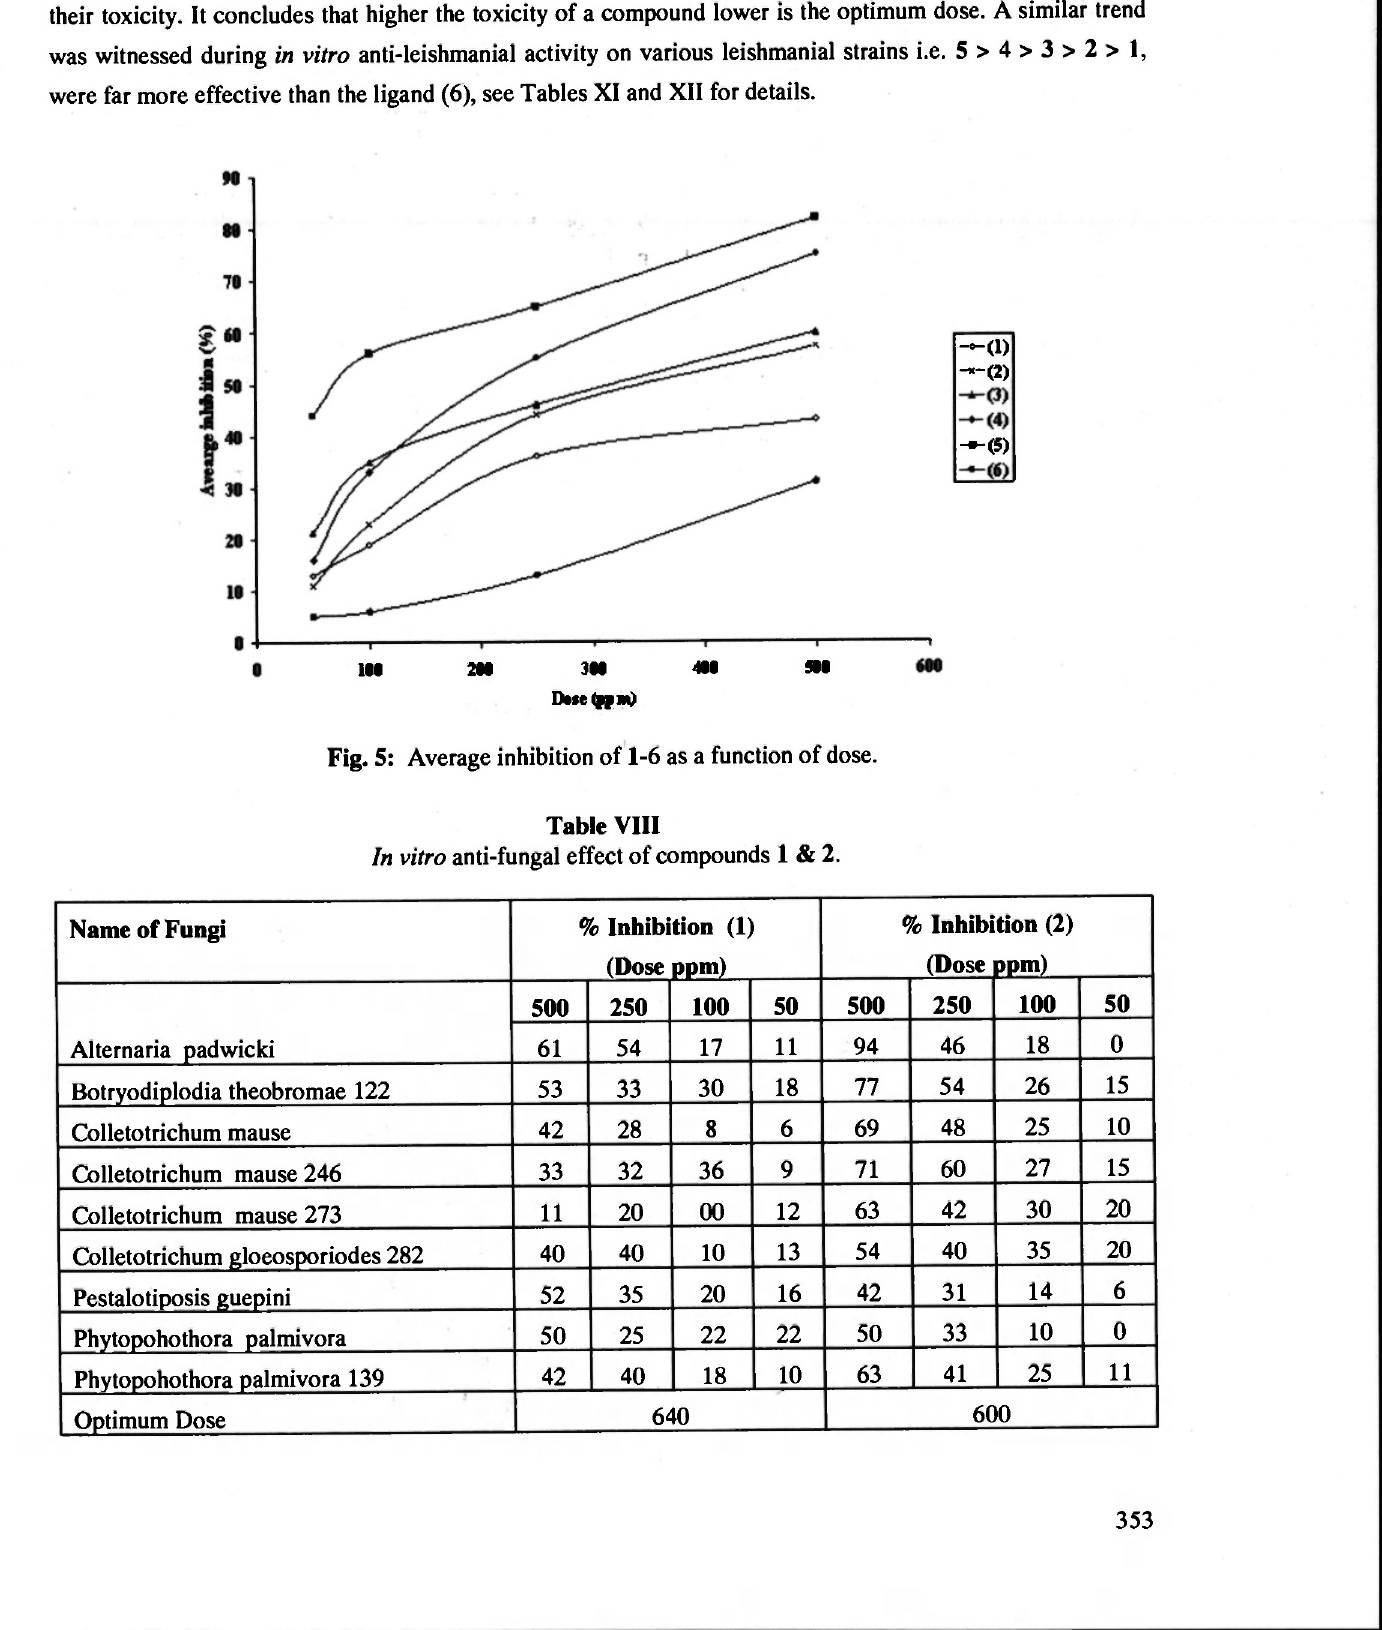
In vitro anti-fungal effect of compounds 1 &